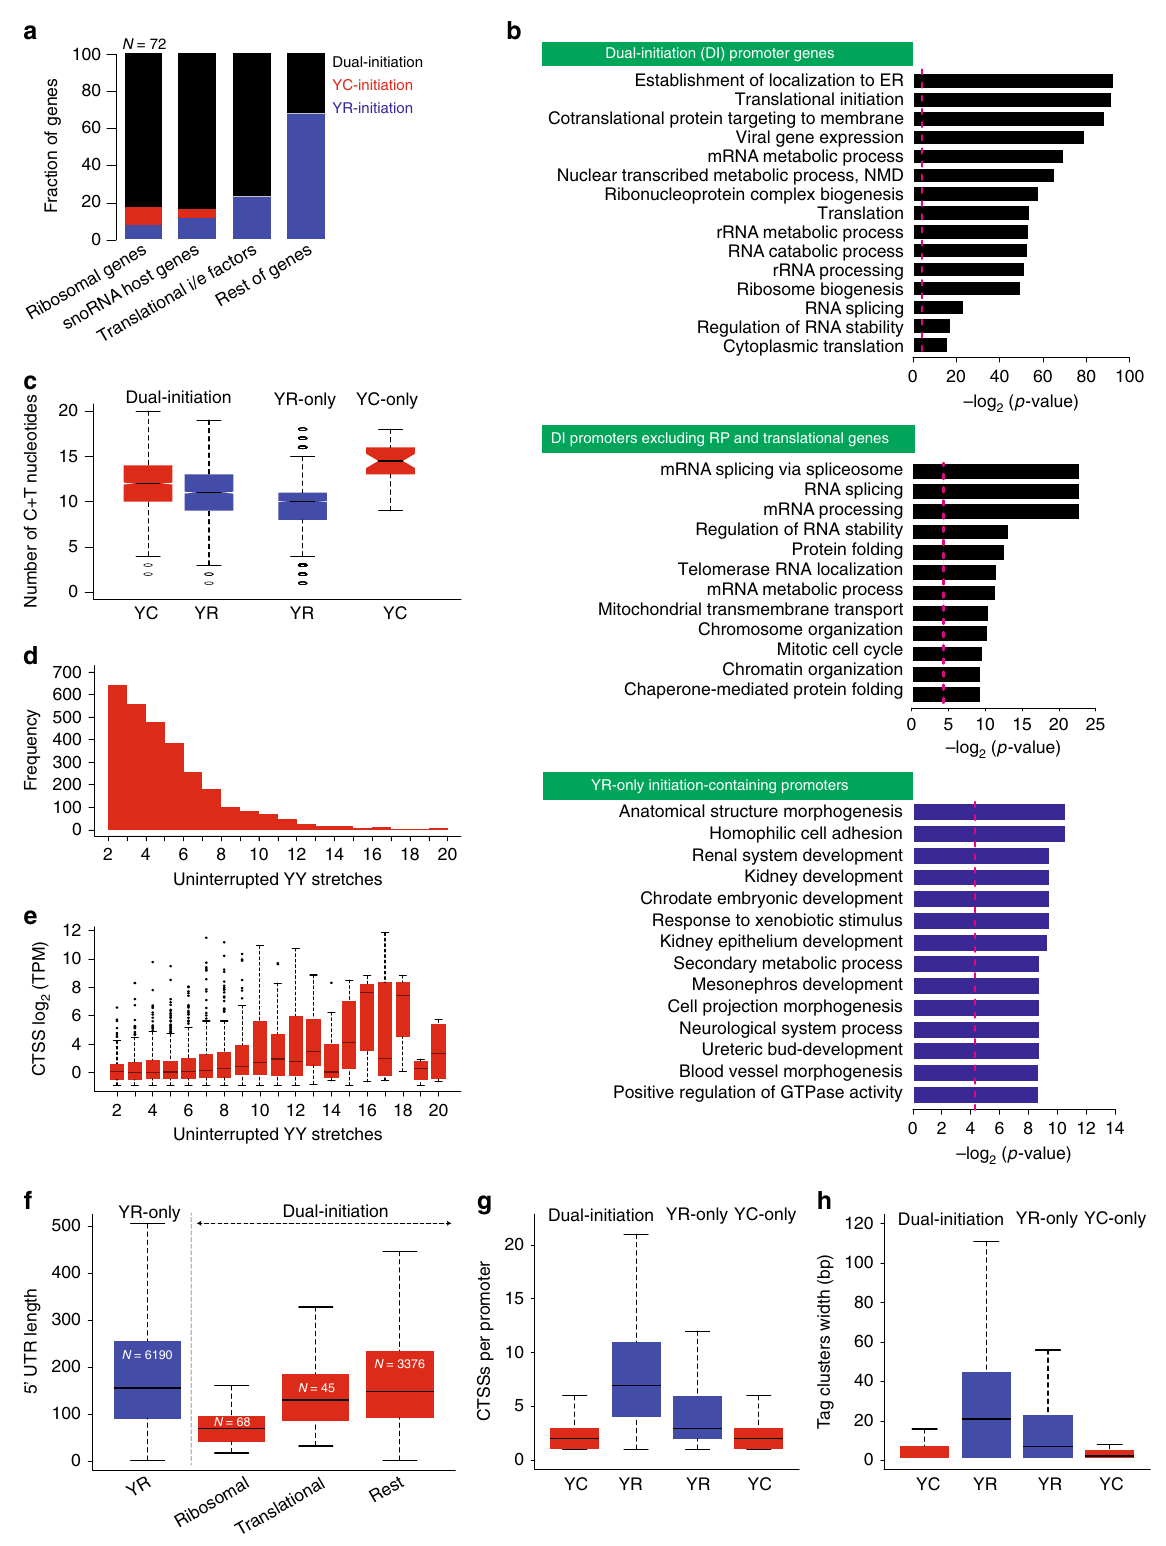
Supplementary Data 4). Enrichment of ribosome-related func- tions is consistent with previous studies describing YC- list revealed an enrichment of additional unexpected GO